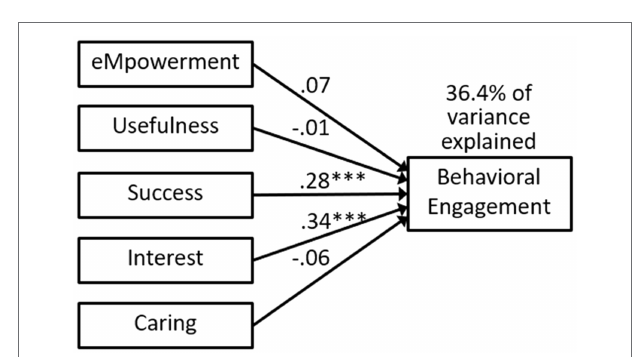
FIGURE 3 | Model 1b regression predicting behavioral engagement. Statistics are standardized beta coefficients. *** p <